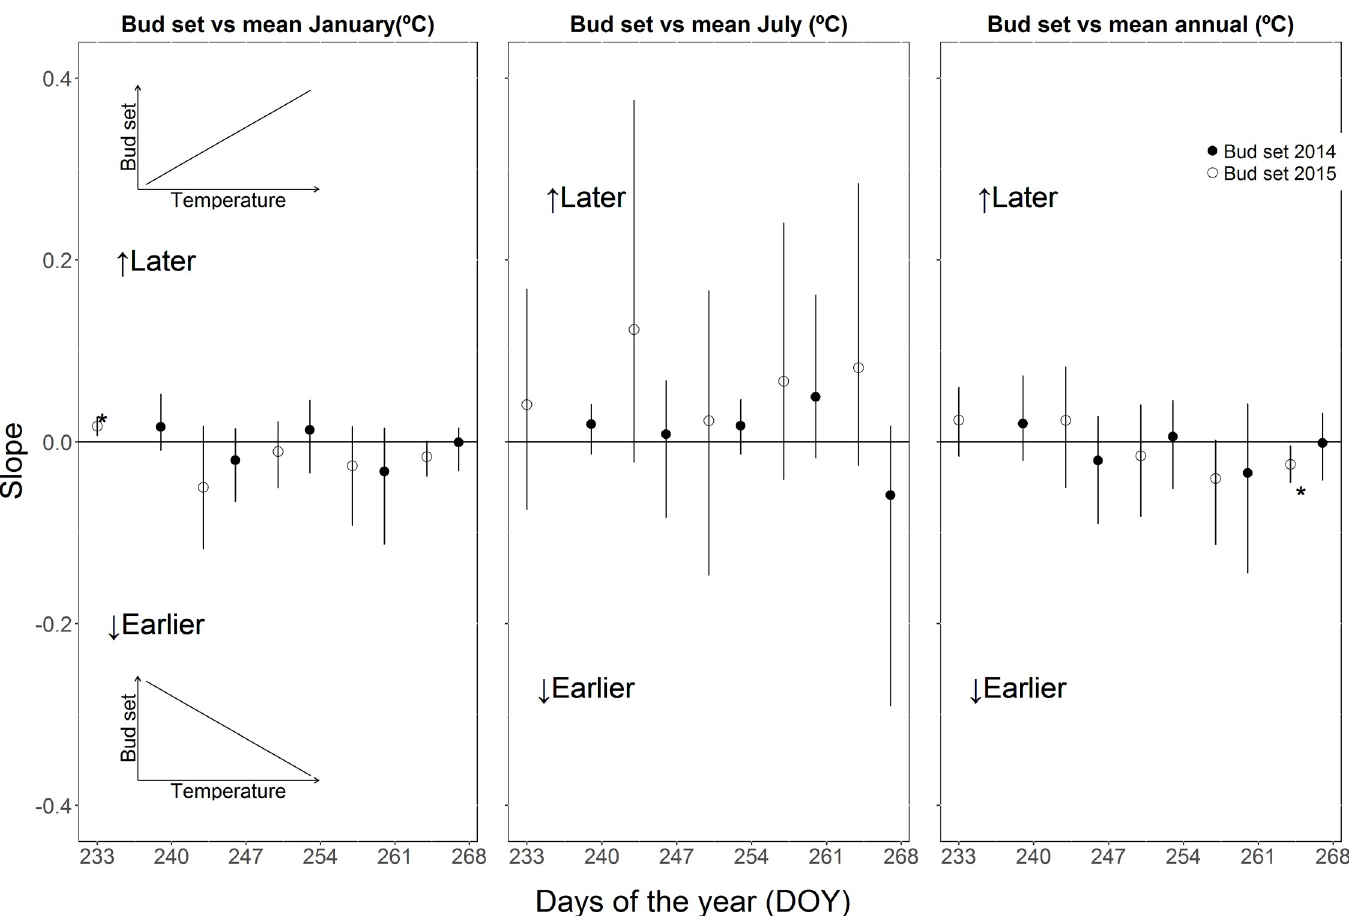
Fig 2. Mean weighted (bootstrapped) slopes of the relationship between the mean bud set score in 2014 and 2015 and mean January, mean July and mean annual temperatures experienced by the parent trees. Error bars denote 95% confidence interval (upper and lower) across the 500 bootstrapped values. Significances at the 95% level are denoted by � . ‘Earlier’ means that buds set earlier with increasing temperatures and ‘Later’ means that buds set later with increasing temperatures.